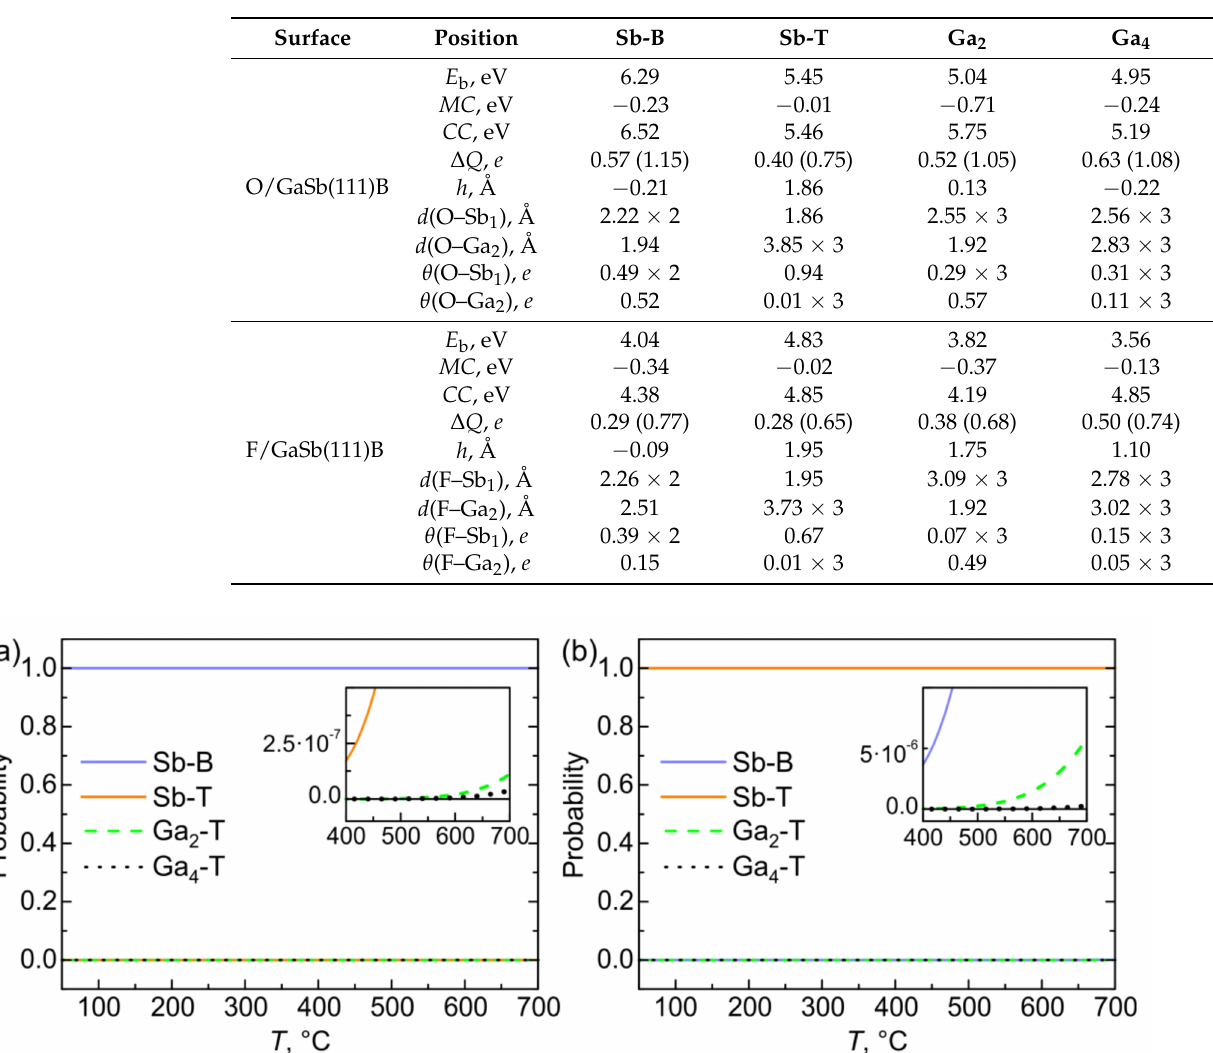
Table 3. Mechanical ( MC ) and chemical ( CC ) contributions to the binding energy ( E b ), charge transfer to adatom ( ∆ Q ) obtained by DDEC6 and Bader (in brackets) methods, height of adatom above surface ( h ), distance between adatom and surface atoms ( d ), as well as corresponding overlap population ( θ ) in the case of oxygen and fluorine adsorption on the GaSb(111)B surface.